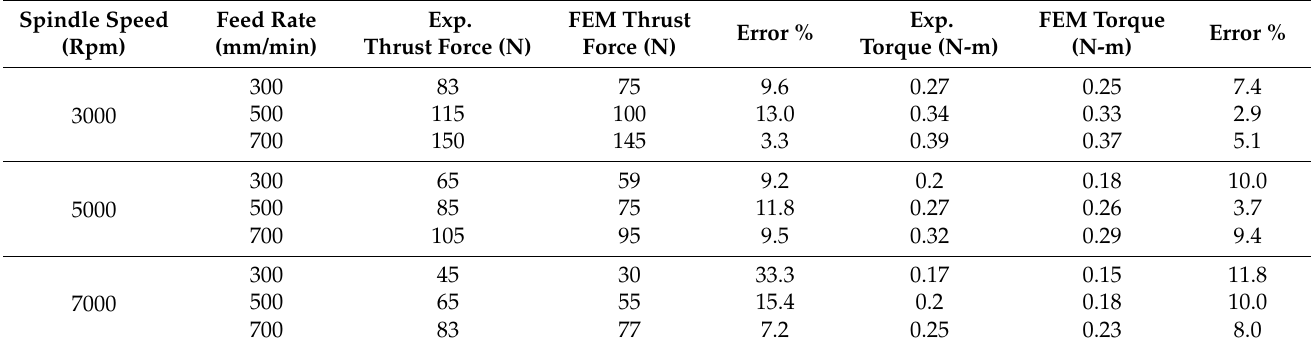
Table 3. Experimental and FEM comparison of torque and thrust